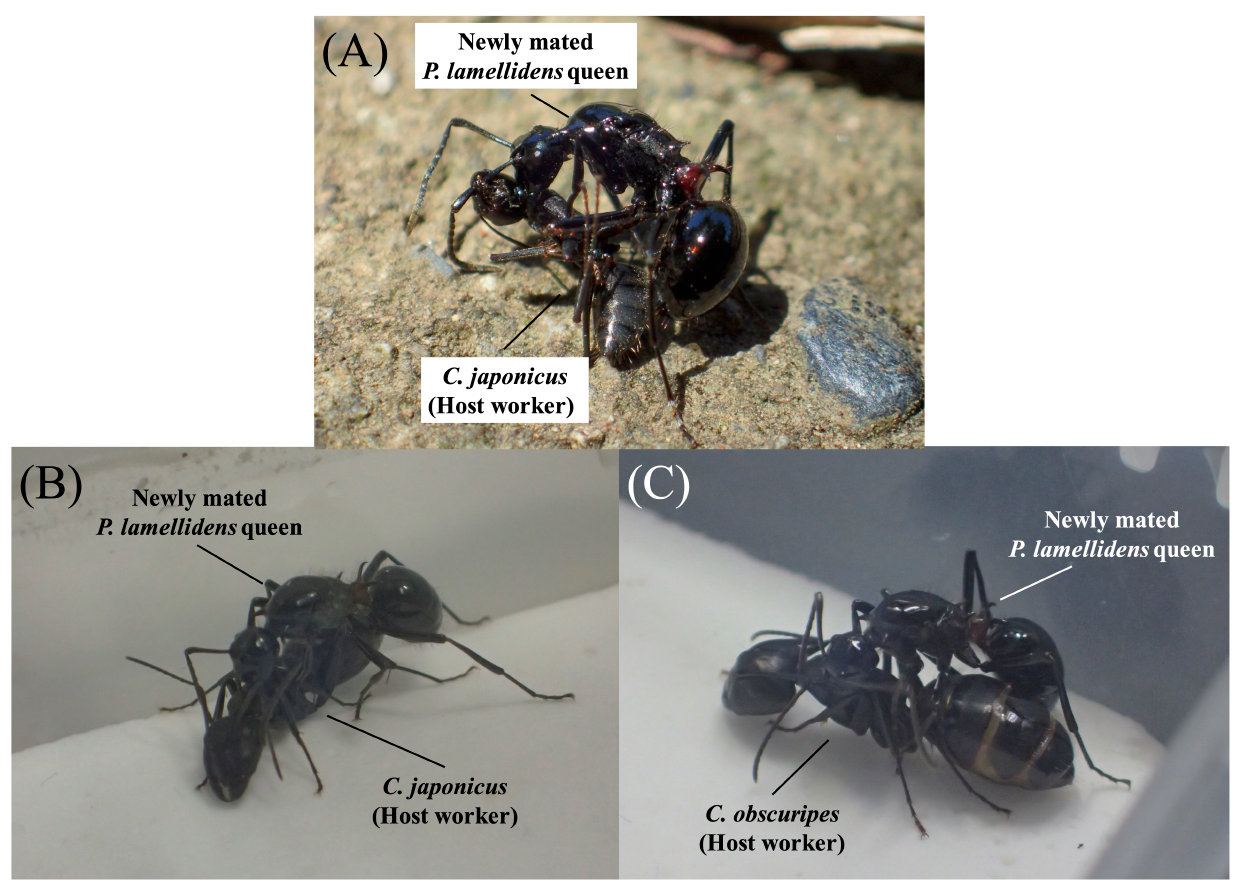
FIGURE 1 | The rubbing behavior of newly mated Polyrhachis lamellidens queens. (A) The newly mated P. lamellidens queen exhibits rubbing behaviour towards its host worker ( C. japonicus ) in a natural environment at a mixed forest in Nagaoka City, Niigata Prefecture (N 37 ◦ 25 (cid:48) 51 (cid:48)(cid:48) , E 138 ◦ 52 (cid:48) 53 (cid:48)(cid:48) ). Adapted from Kurihara et al. (2022) (https://doi.org/10.1242/bio.058956). (B) Rubbing behavior against C. japonicus workers under laboratory conditions. (C) Rubbing behavior against Camponotus obscuripes workers under laboratory conditions.